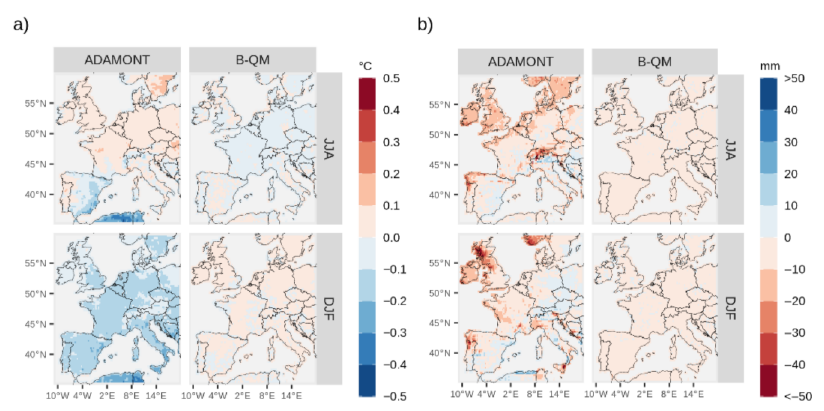
Figure 11. Spatial distribution of ME for ( a ) 2-m mean air temperature and ( b ) precipitation in JJA and DJF for calibrated seasonal forecasts (one-month lead time) by ADAMONT and B-QM over 1993–2016.